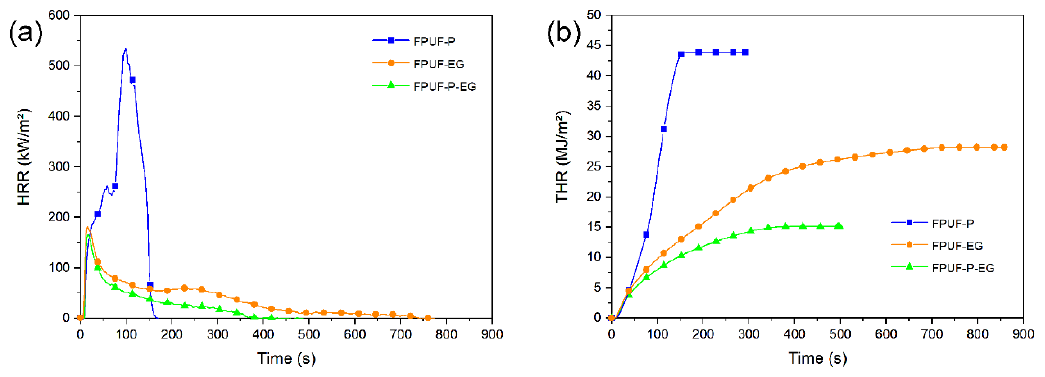
Figure 12. ( a ) Heat release rate and ( b ) total heat release of FPUF-P, FPUF-EG, and FPUF-P-EG.